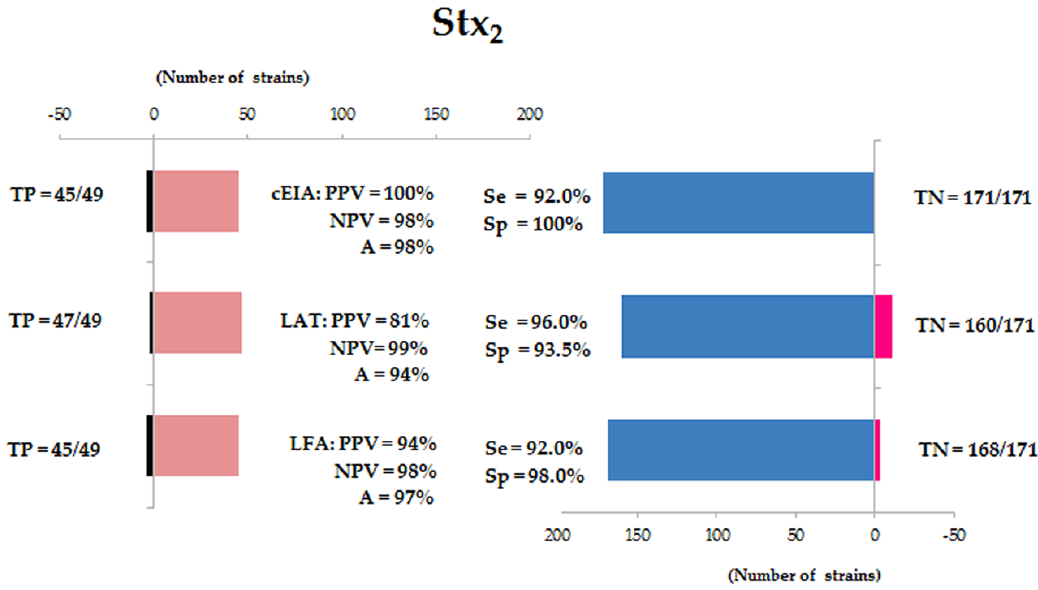
Figure 3. Representative image of positive (EDL933 – O157:H7) and negative (atypical EPEC – aEPEC- O127:H7) controls strains in a lateral flow assay (LFA) employing Stx 1 or Stx 2 antibodies. Triplicates of each experiment.